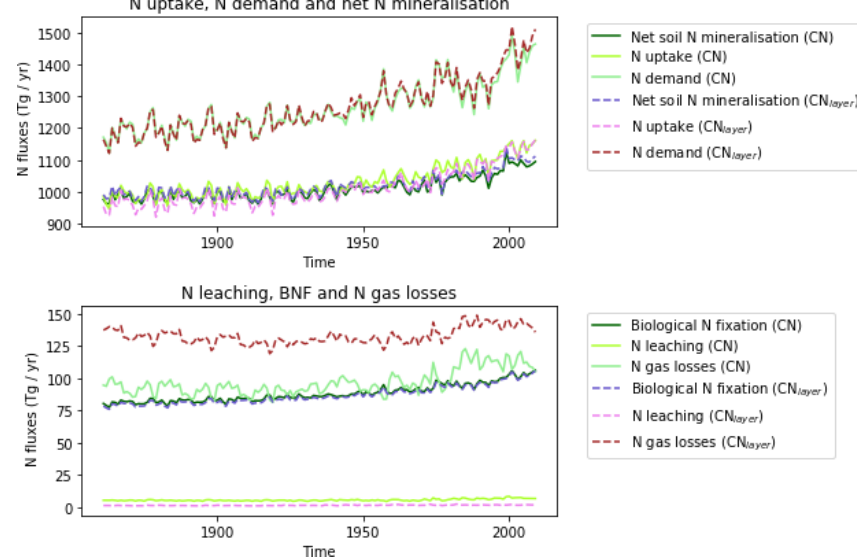
Figure 13. N fluxes for JULES-CN and JULES-CN layer over the historical